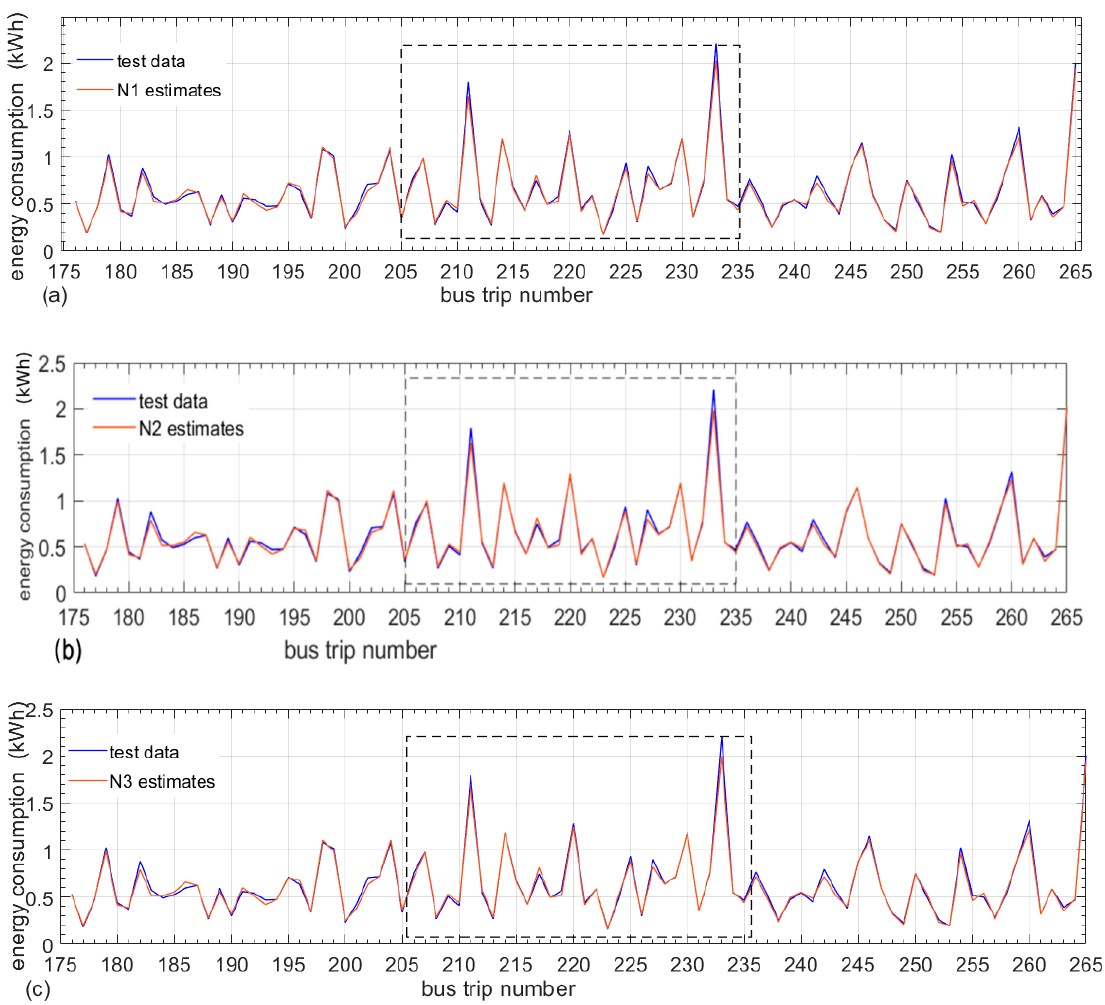
Figure 9. Test data and estimated values using the DLN: ( a ) N1, ( b ) N2 and( c ) N3.